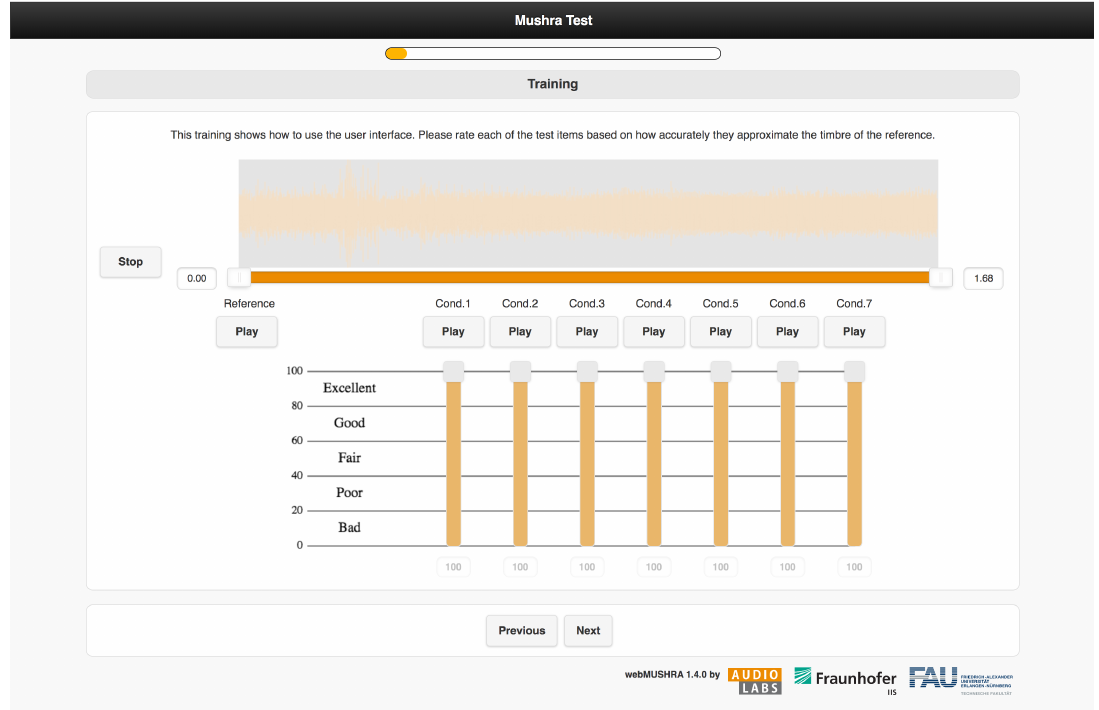
Figure 12. The WebMUSHRA interface used during the listening tests.